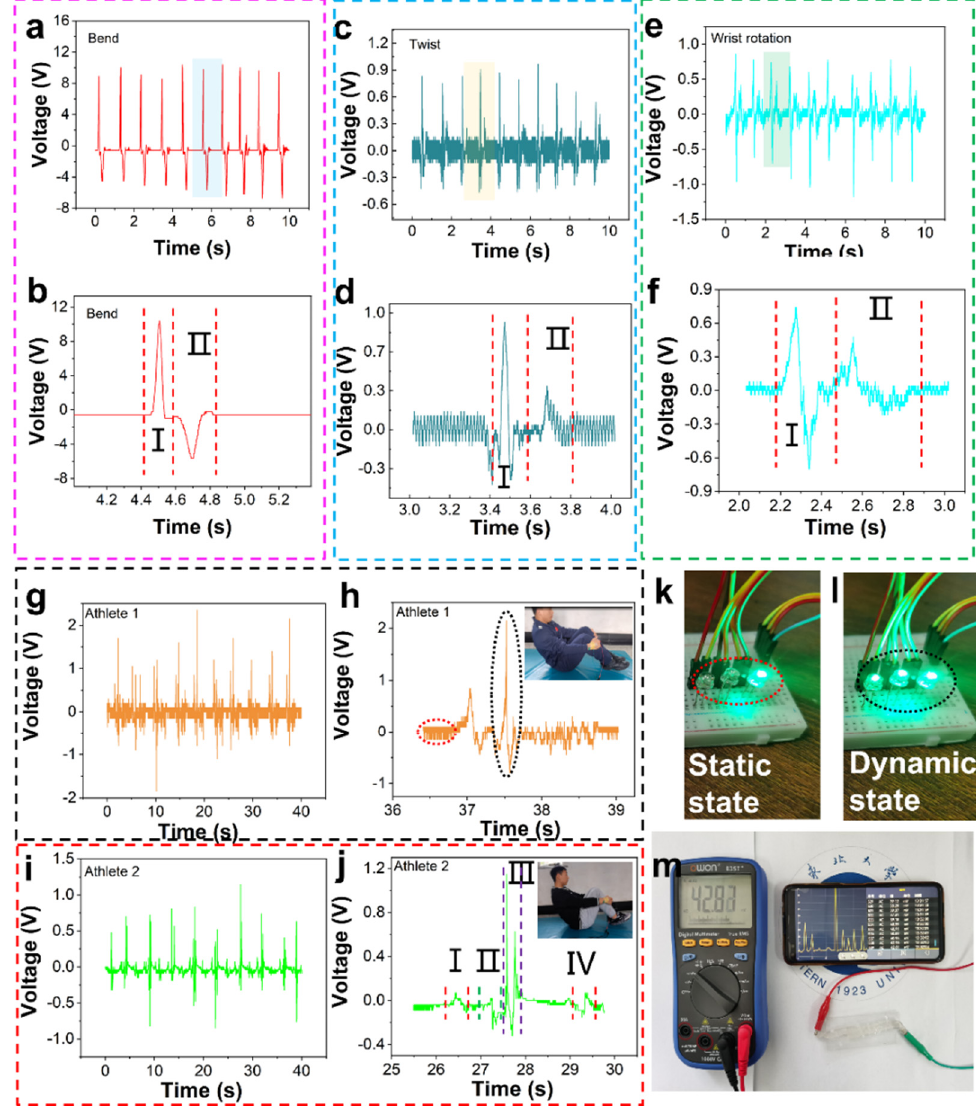
Figure 7. The actual test and wireless signal transmission system. ( a , b ) Wrist bending test and its response. ( c , d ) Wrist twist test and its response. ( e , f ) Wrist rotation test and its response. ( g , h ) Out- putting voltage and details of Athlete 1 ′ s 301C diving motion. ( i , j ) Outputting voltage and details of Athlete 2’s 301c diving motion. ( k – m ) Wireless Bluetooth transmission system.